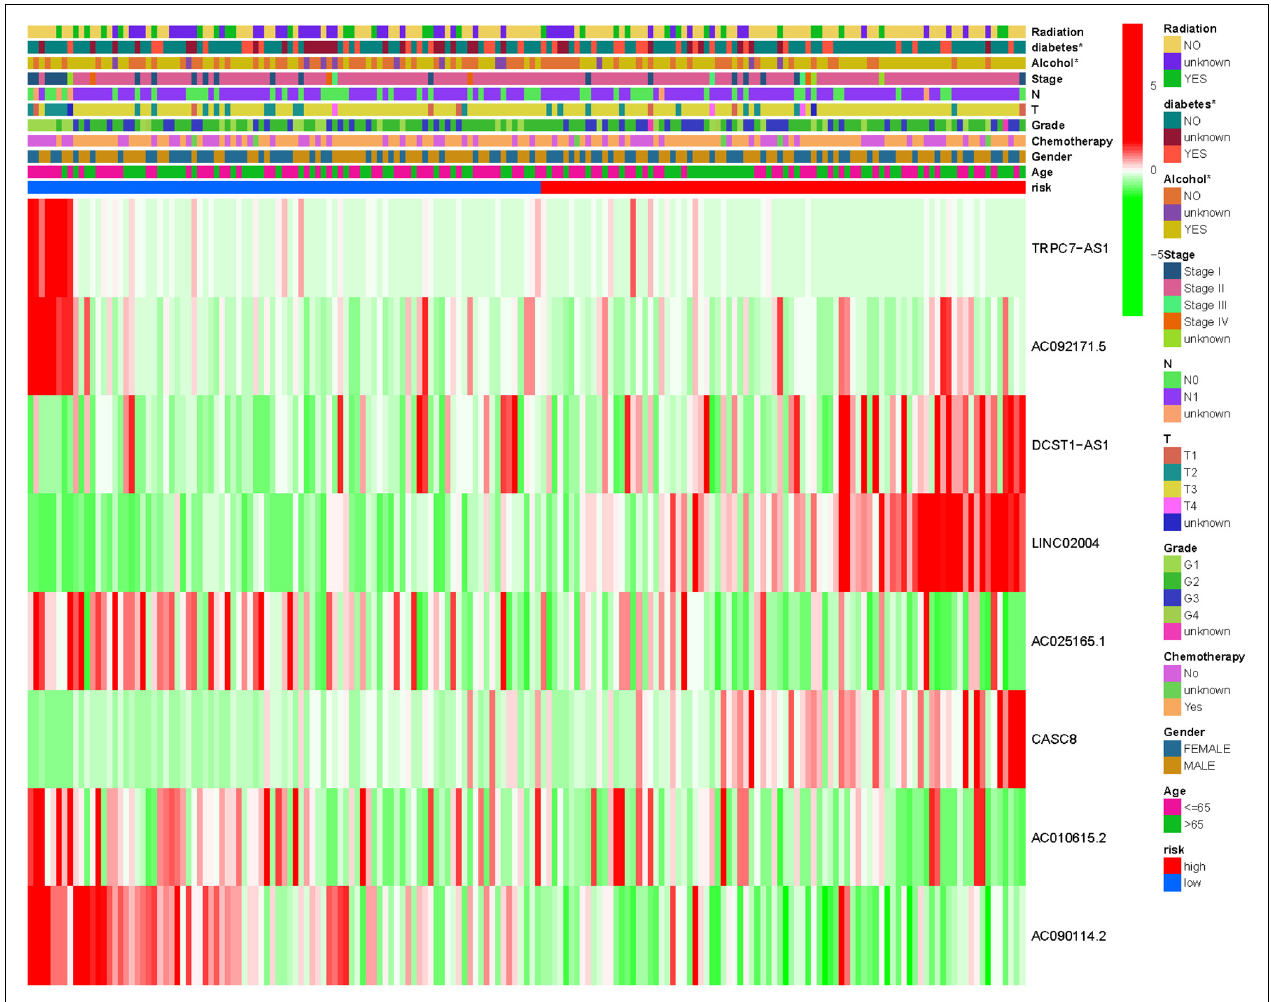
FIGURE 3 | Heatmap for the m6A-associated lncRNAsprognostic signature and clinicopathological manifestations in pancreatic cancer. * P < 0.05.